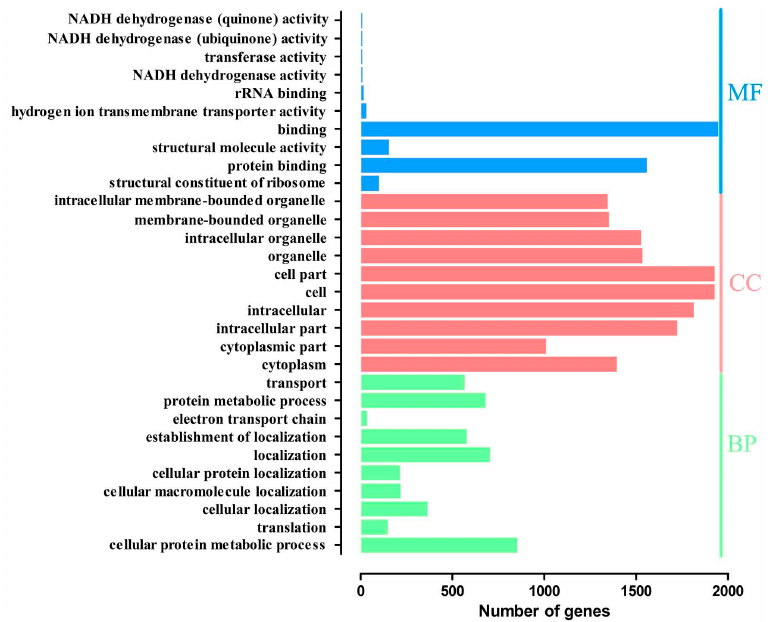
Figure 3. Volcano plot displaying differential expressed neuropeptide and neuropeptide receptor genes between EA and the control group. The y -axis corresponds to the value of log 10 ( p value), and the x -axis displays the log 2 (fold change). The red dots represent the up-regulated neuropeptides genes ( p < 0.005). The green dots represent the down-regulated neuropeptides genes ( p < 0.005). The red triangles represent the up-regulated neuropeptide receptor genes ( p < 0.005). The green triangles represent the down-regulated neuropeptide receptor genes ( p < 0.005).